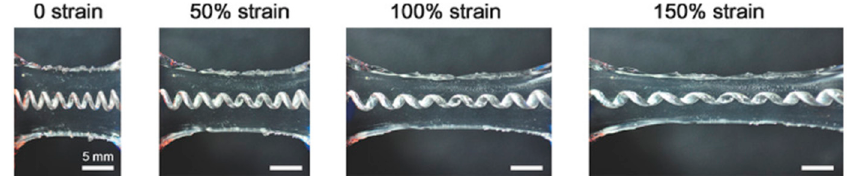
Figure 4. Demonstration of eutectic gallium indium (EGaIn) encased in polyacrylamide-alginate hydrogel undergoing strain. Reproduced with permission from [107]. Copyright 2018, John Wiley and Sons.